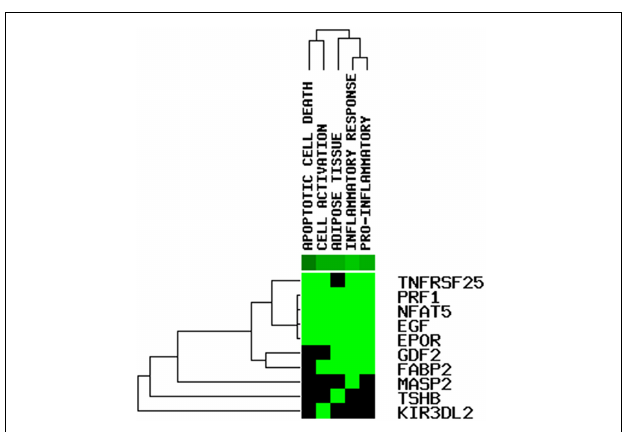
FIGURE 9 | Functional enrichment analysis on the mRNAs in the ceRNA network.